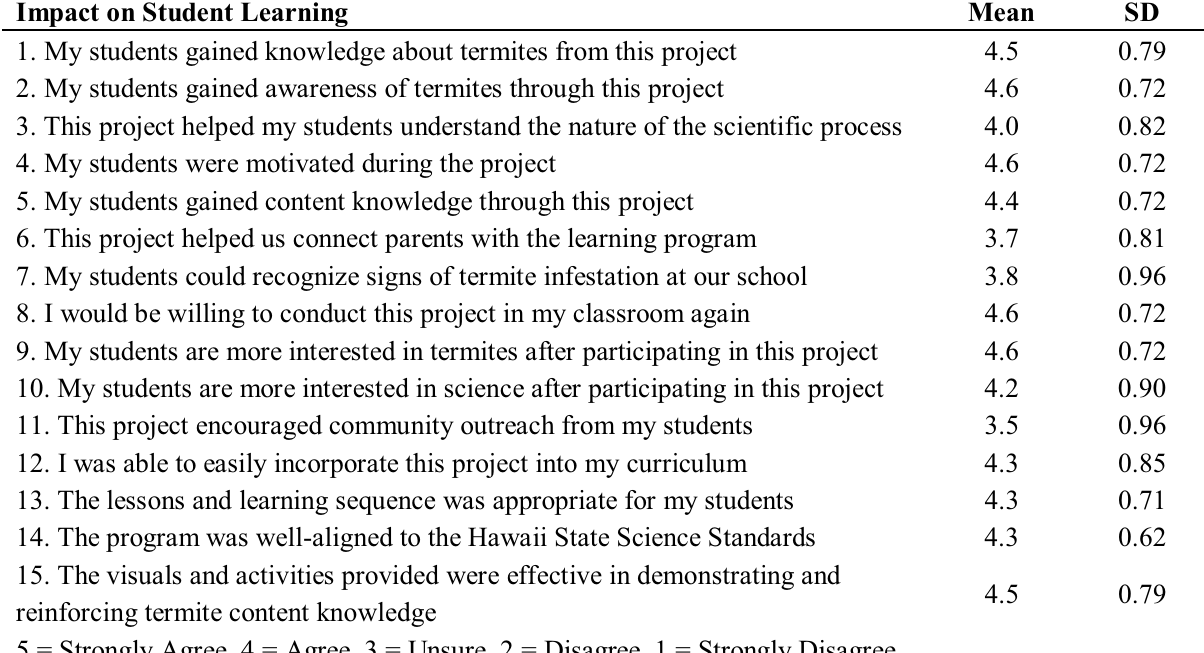
Table 6. Educate to Eradicate partner teacher perceptions of curriculum (survey B).